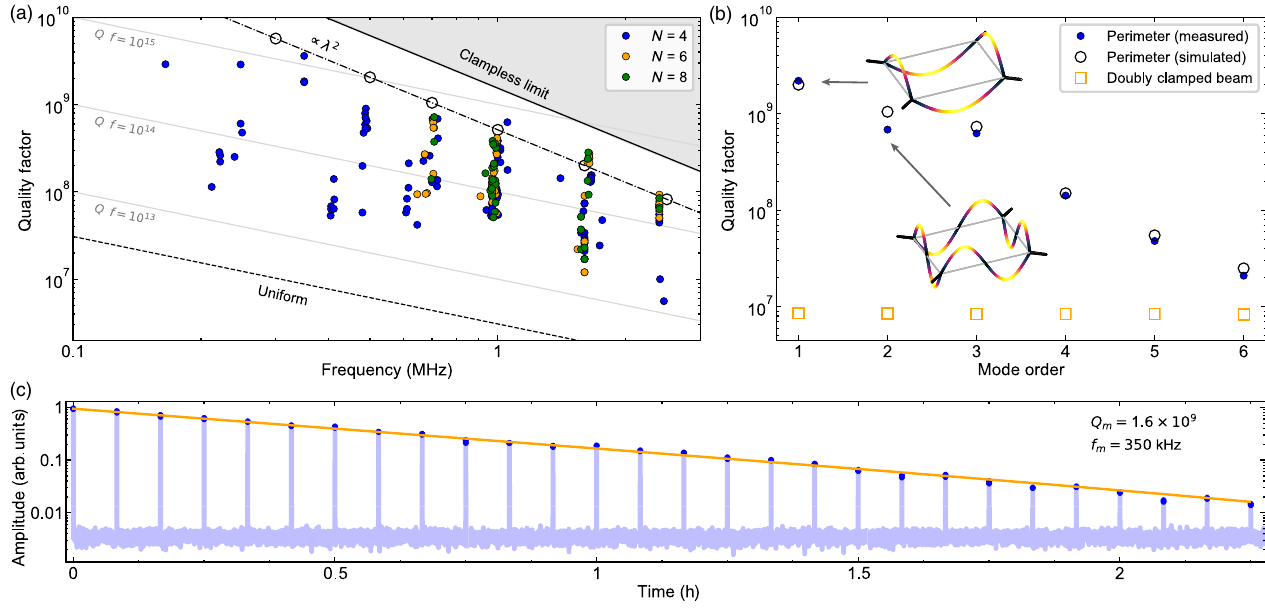
FIG. 3. Characterization of fundamental and higher-order perimeter modes. (a) A survey of all the measured Q ’ s of fundamental perimeter modes for square-, hexagon-, and octagon-shaped Si 3 N 4 resonators (blue, orange, and green circles, respectively), with ∈ ½ 0 . 2 ; 0 . 4 ; 0 . 6 ; 0 . 8 (cid:2) and w 200 and 300 nm. The solid black line shows the clampless limit for a 20 nm Si r 0 ¼ 3 N 4 film assuming l 2500 . FEM simulation Q ’ s (open circles) are plotted for optimal geometrical parameters ( r 0 . 6 and intrinsic quality factor of Q l ¼ int ¼ w 0 ¼ 200 nm). The dot-dashed line interpolates the FEM simulation Q ’ s and shows the λ 2 scaling. The dashed line is the fundamental 0 . 2 , and w mode Q of a uniform nanobeam. (b) High-order perimeter mode Q ’ s (blue dots) of a square with l 0 ¼ 700 μ m, r 0 ¼ l ¼ 200 nm are shown with FEM predictions (open circles). Open squares show the calculated Q ’ s of a uniform beam with the same thickness and fundamental mode frequency. Displacement profiles of the first two perimeter modes are shown as insets. (c) Gated 0 . 2 , and w 200 nm with a fundamental perimeter ringdown measurement (1 s on, 5 min off) of a square with l 0 ¼ 700 μ m, r 0 ¼ l ¼ mode Q of 1 . 6 × 10 9 at 350 kHz. Orange line: exponential fit to the data shown by blue circles. Faded blue data are excluded from the fit as the laser is blocked at these